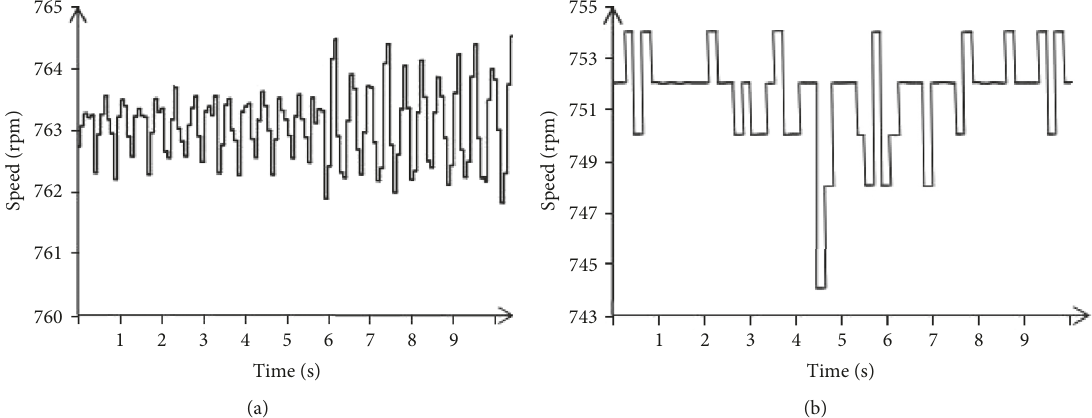
Figure 9: Speed fluctuation curve of cylinder II. (a) Under no-load condition. (b) Under threshing